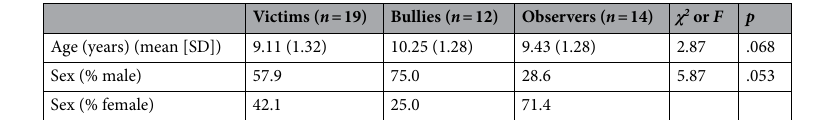
Table 1. Demographic characteristics of the sample. SD standard